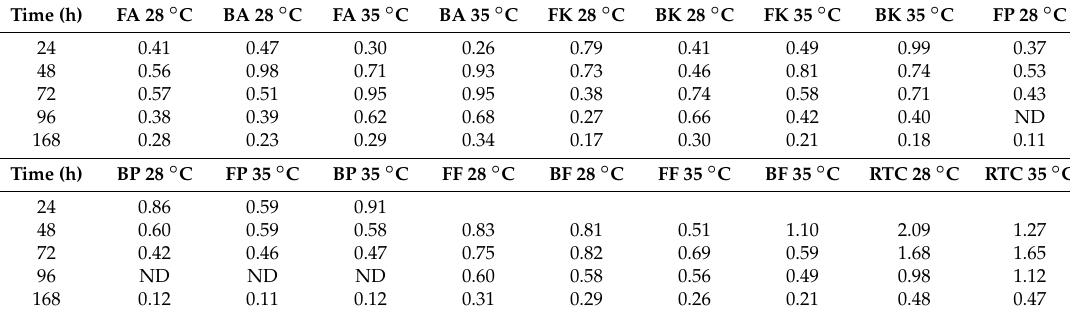
Table 2. Ethanol productivity (g/L/h) in batch fermentations. FA: fresh apple; BA: blanched apple; FK: fresh kiwifruit; BK: blanched kiwifruit; FP: fresh peach; BP: blanched peach; FF: fresh fruit mix; BF: